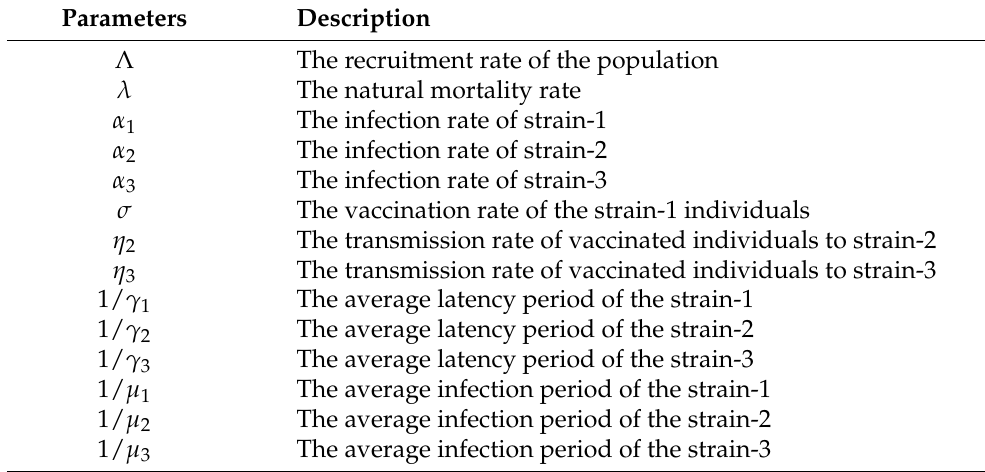
Figure 1. The diagram of SVEIR three-strain model. Table 1. Description of the parameters in the